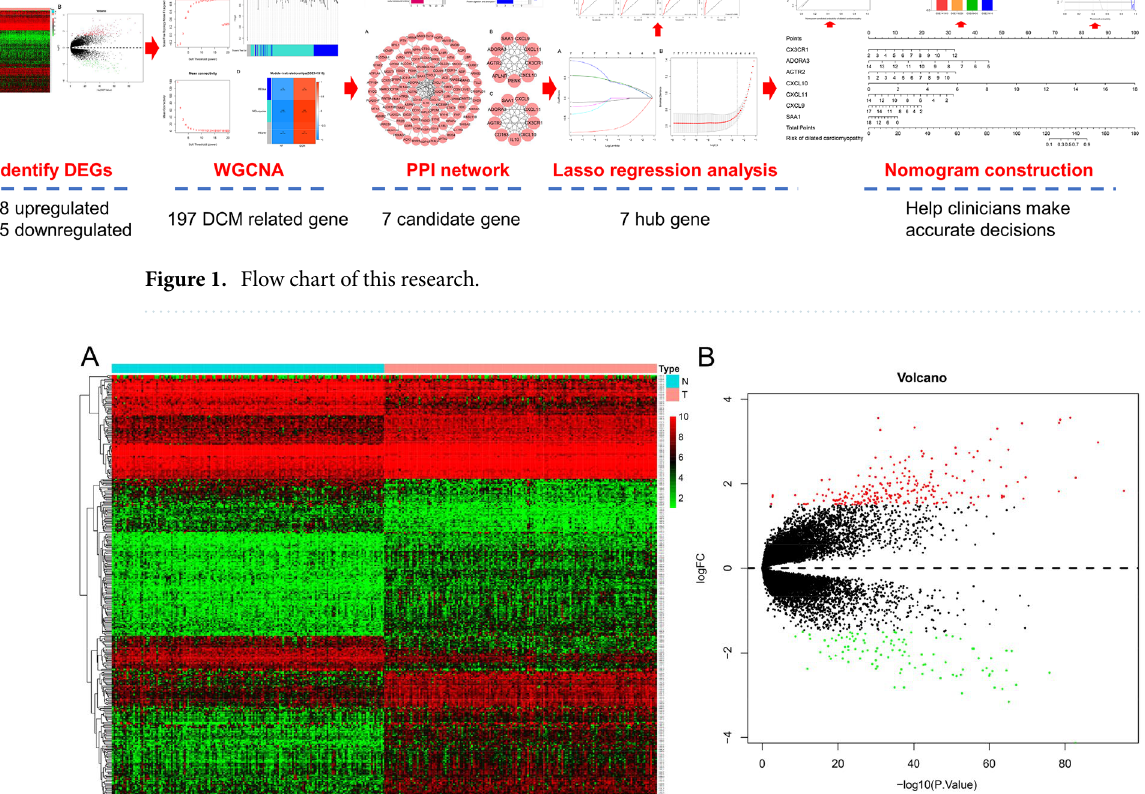
Figure 2. Identify the 333 differential genes of dilated cardiomyopathy. ( A ) Heat map. ( B ) Volcano